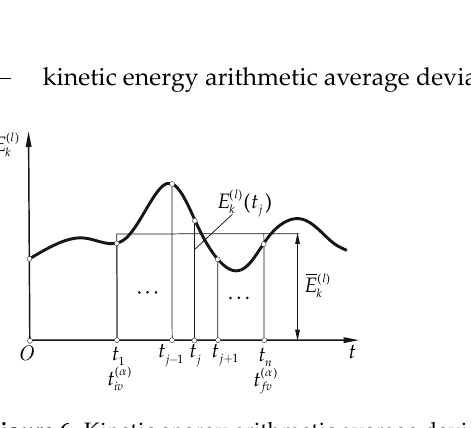
Figure 6. Kinetic energy arithmetic average deviation from the integral mean value indicator.